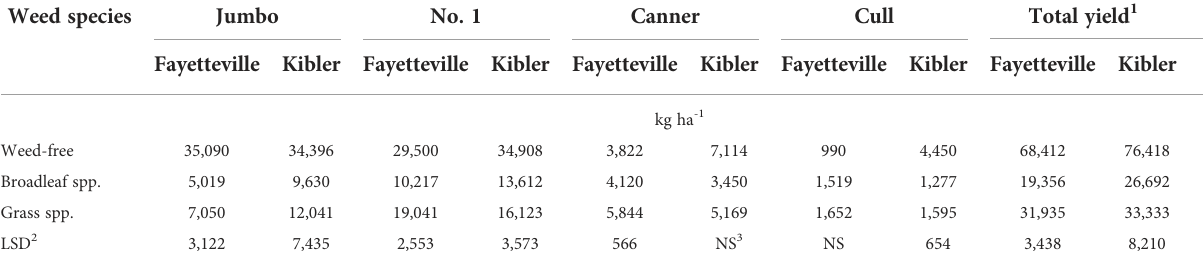
TABLE 7 Effect of weed infestation on yield averaged across nine sweetpotato cultivars, by grade (kg ha -1 ), in Fayetteville and Kibler, AR, 2021. Weed species Jumbo